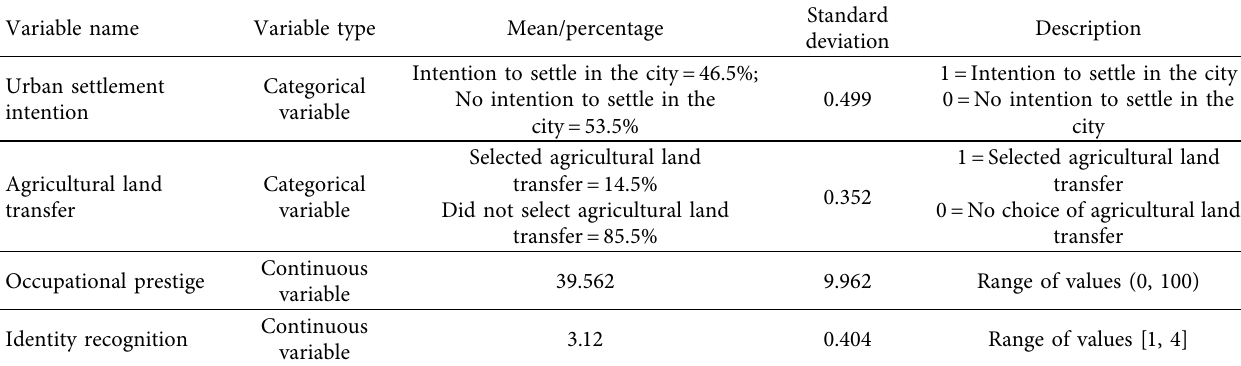
Table 1: Definition of main variables and descriptive